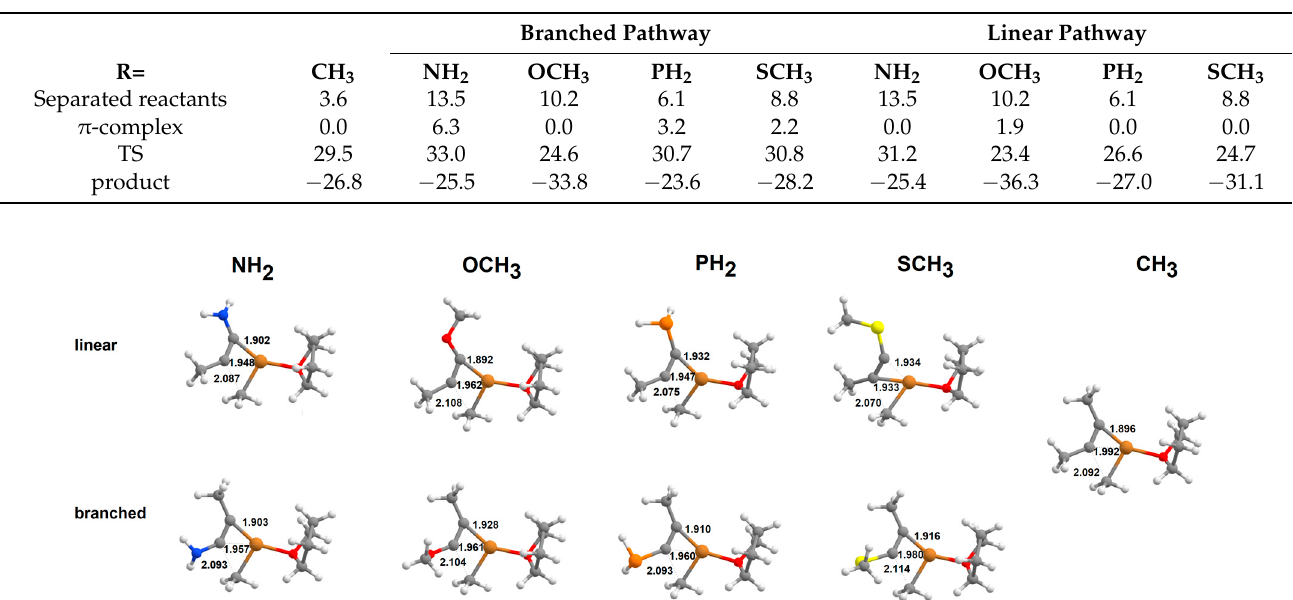
Table 1. Relative energies (kcal · mol − 1 ) of infinitely-separated reactants, π -complexes, transition states and products of the addition of THF-solvated Cu(CH 3 ) to alkynes of the form R-C ≡ C-CH 3 . For each alkyne, all energies are shown relative to the energy of its most stable π -complex. Single-point energies were computed at the PBEPW91/6-311G(2d,p)//6-31G(d), including solvation effects in THF and zero-point and vibrational effects at 223 K.